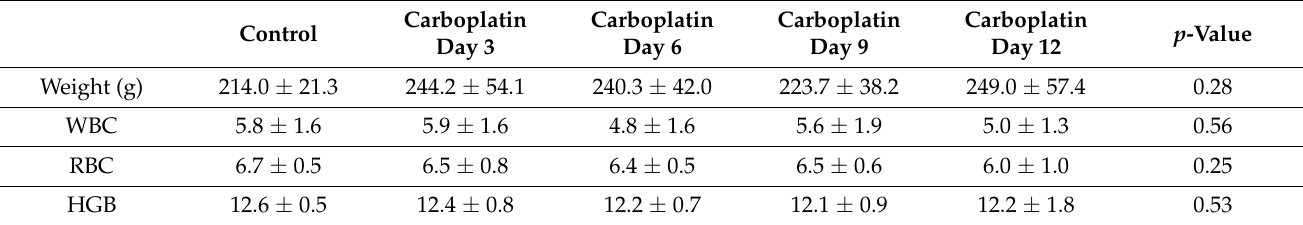
Table 1. Blood cell